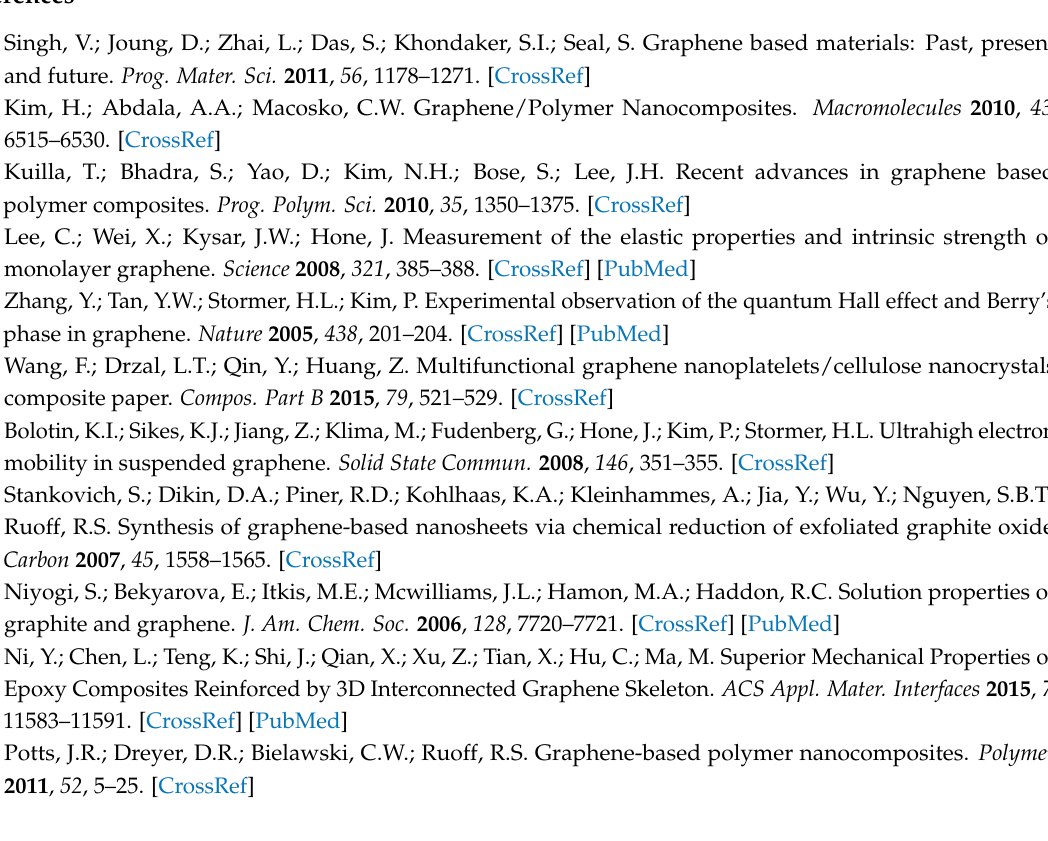
Figure S1: (a) Impact strength and tensile strength of EP, EP/GNs and (b) EP/GPLP composites (GNs 1.47 wt %). Author Contributions: Y.L. conceived the project and designed the experiments; J.G. and X.X. performed the experiment and analyzed the data; J.G. wrote the main manuscript text, S.L. provided the guidance of experiments. X.L. performed the test